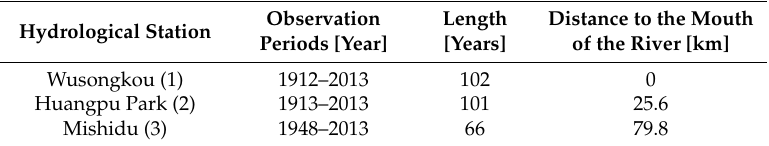
Table 2. Description of datasets for flood frequency analysis in the Huangpu